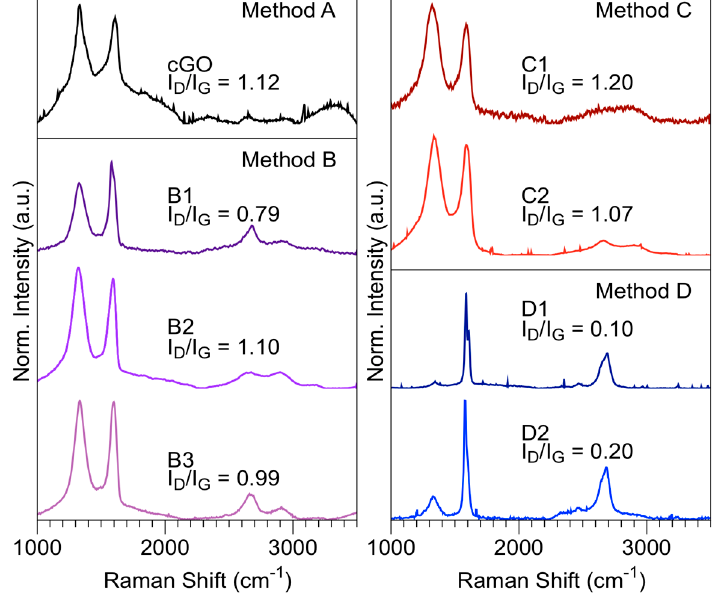
Figure 6. Raman spectra of method A (cGO), method B (B1, B2, B3), method C (C1, C2), and method D (D1, D2).